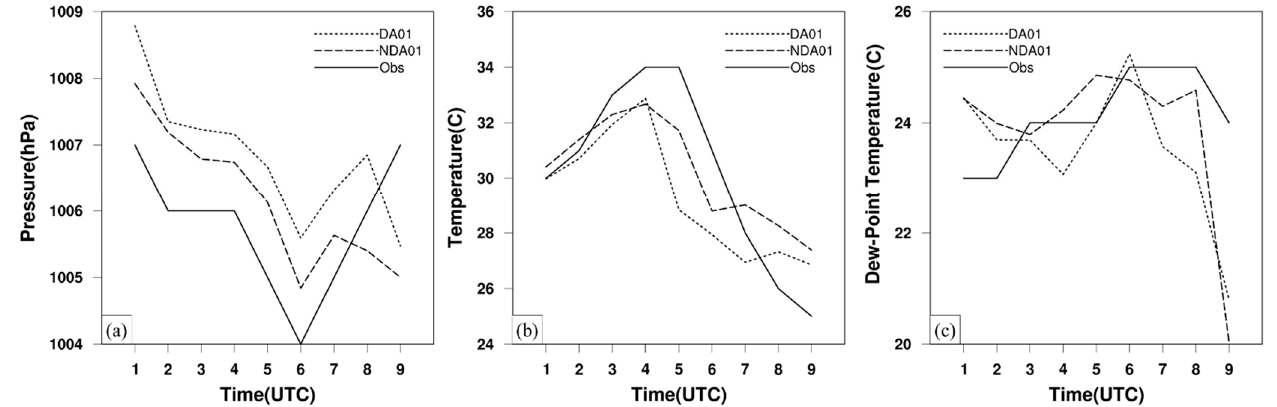
Figure 6. The observed (solid lines), DA01 assimilated (dot lines) and NDA01 non-assimilated (dashed lines) hourly surface ( a ) pressure, ( b ) temperature, ( c ) dew-point temperature of Pingtung Airport from 0100 to 0900 UTC (0900 to 1700 LST) on 5 August 2018.